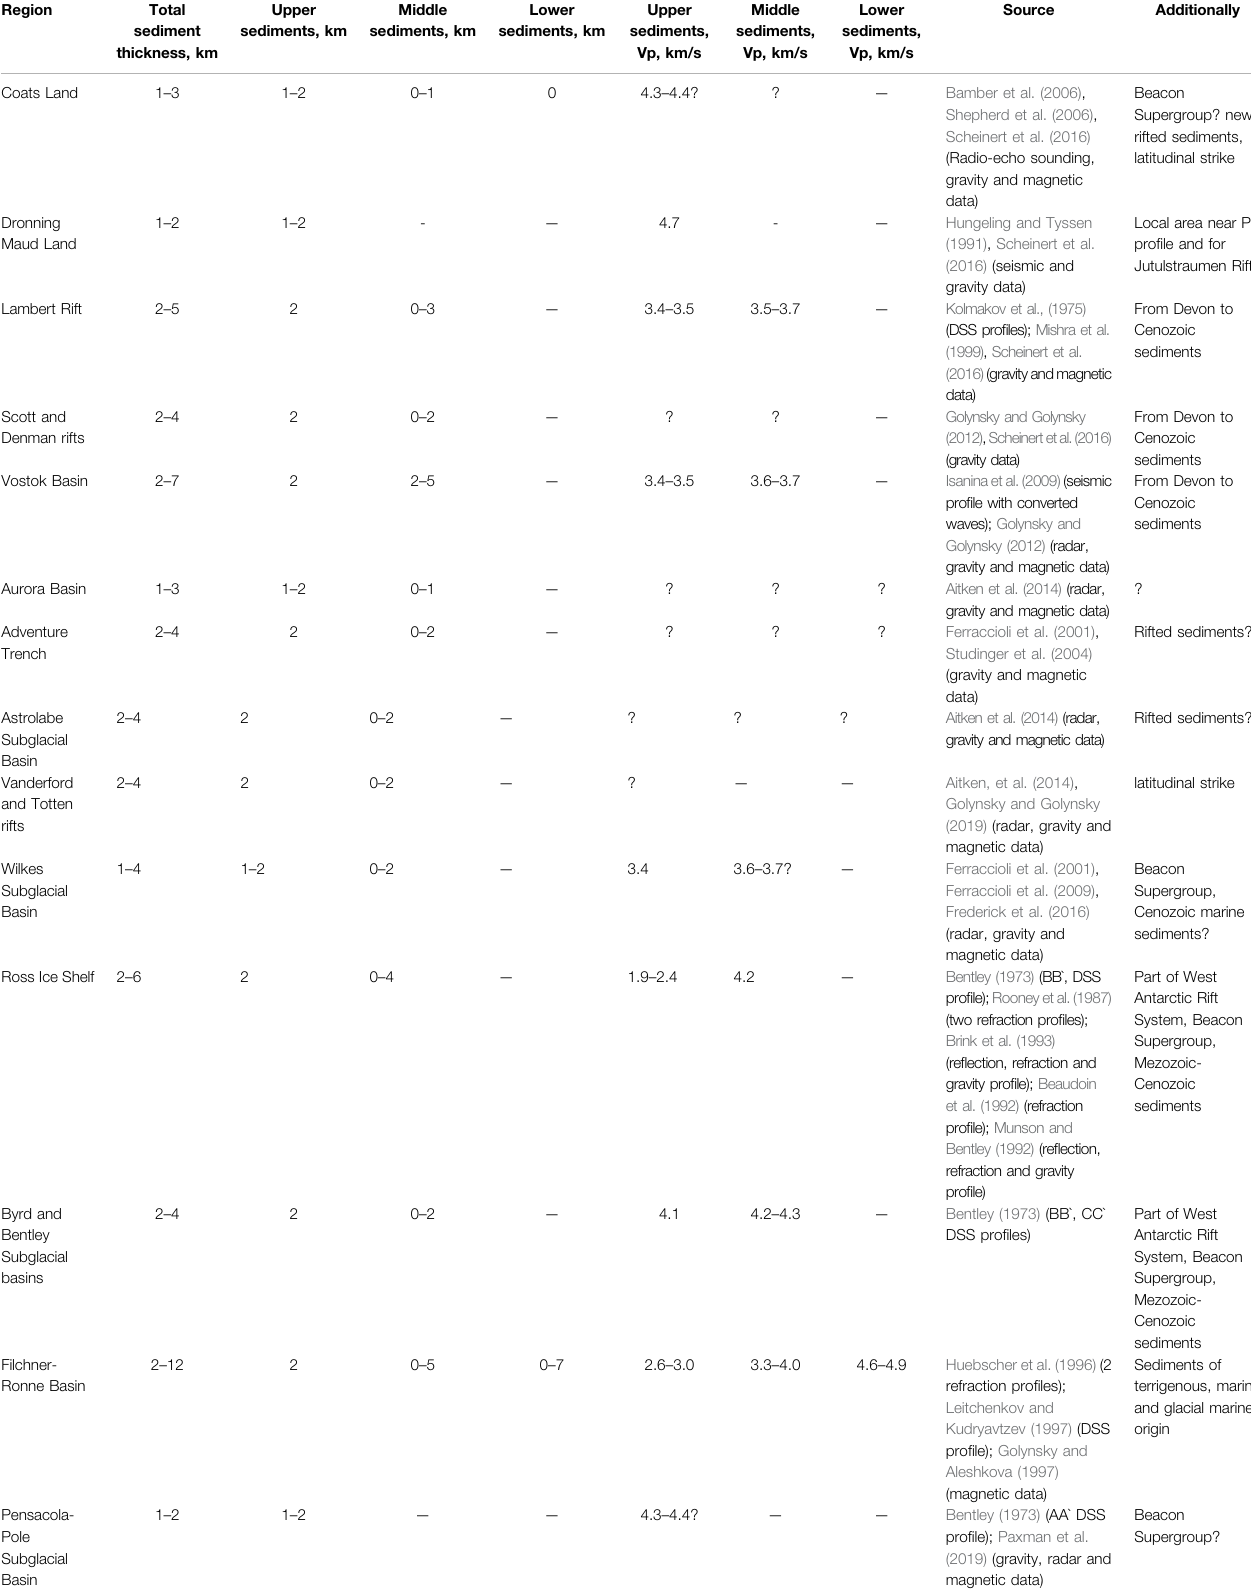
TABLE 1 | Data sources used in this